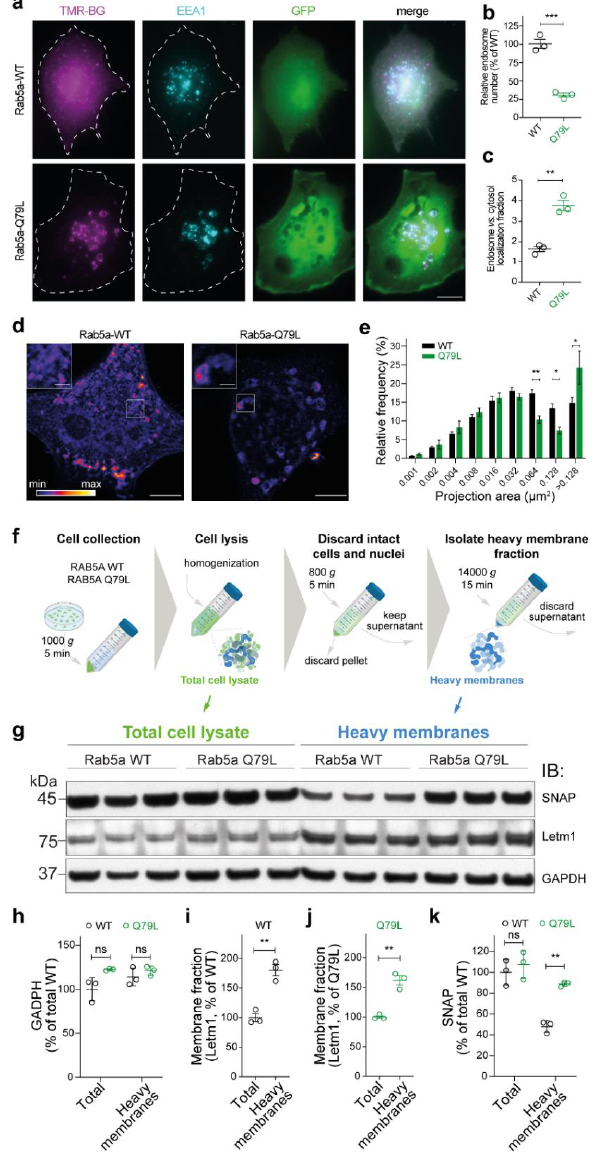
Figure 5. Rab5a-Q79L mutant associates more with the membrane. ( a ) Representative epifluorescence images of Rab5a-WT and Rab5a-Q79L. ( b ) Quantification of endosome number. ( c ) Quantification of endosomal vs. cytosolic distribution of the sensors. ( d ) Representative STED images of the SNAP- ligand signal for Rab5a-WT and Rab5a-Q79L lifetime sensors. ( e ). Relative frequency distribution of Rab5a-WT and Rab5a-Q79L puncta area ( µ m 2 ) per field of view, indicating the increase in size of vesicular-like structures in the RAB5a-Q79L mutant vs. the WT. ( f ) Schematic representation of total cell lysate and heavy membrane extraction from RAB5a-WT or RAB5a-Q79L expressing cells for Western blot experiment. (P)—pellet, (S)—supernatant. ( g ) Western blot for detecting SNAP-tag (45 kDa), Letm1 (75 kDa), GAPDH (37 kDa) in the total cell lysate or heavy membrane fraction of RAB5a-WT or RAB5a-Q79L samples. The original can be found in Supplementary Figure S3. ( h – k ) Quantitative analysis of Western blot in g . Scale bars: 10 µ m ( a ), 5 µ m ( d ) and 1 µ m (in the insets in d ). The data are presented as mean ± SEM ( b , c , e , h – k ). n = 3 (coverslips; b-c); n = 7 (cells in ( d ), WT) and n = 3 (cells in d , Q79L). n = 3 independent samples ( g , h – k ). Unpaired Student’s t -test ( b , c , i , j ) two-way ANOVA and post hoc Bonferroni test ( e , h , k ), ns-not significant, * p <